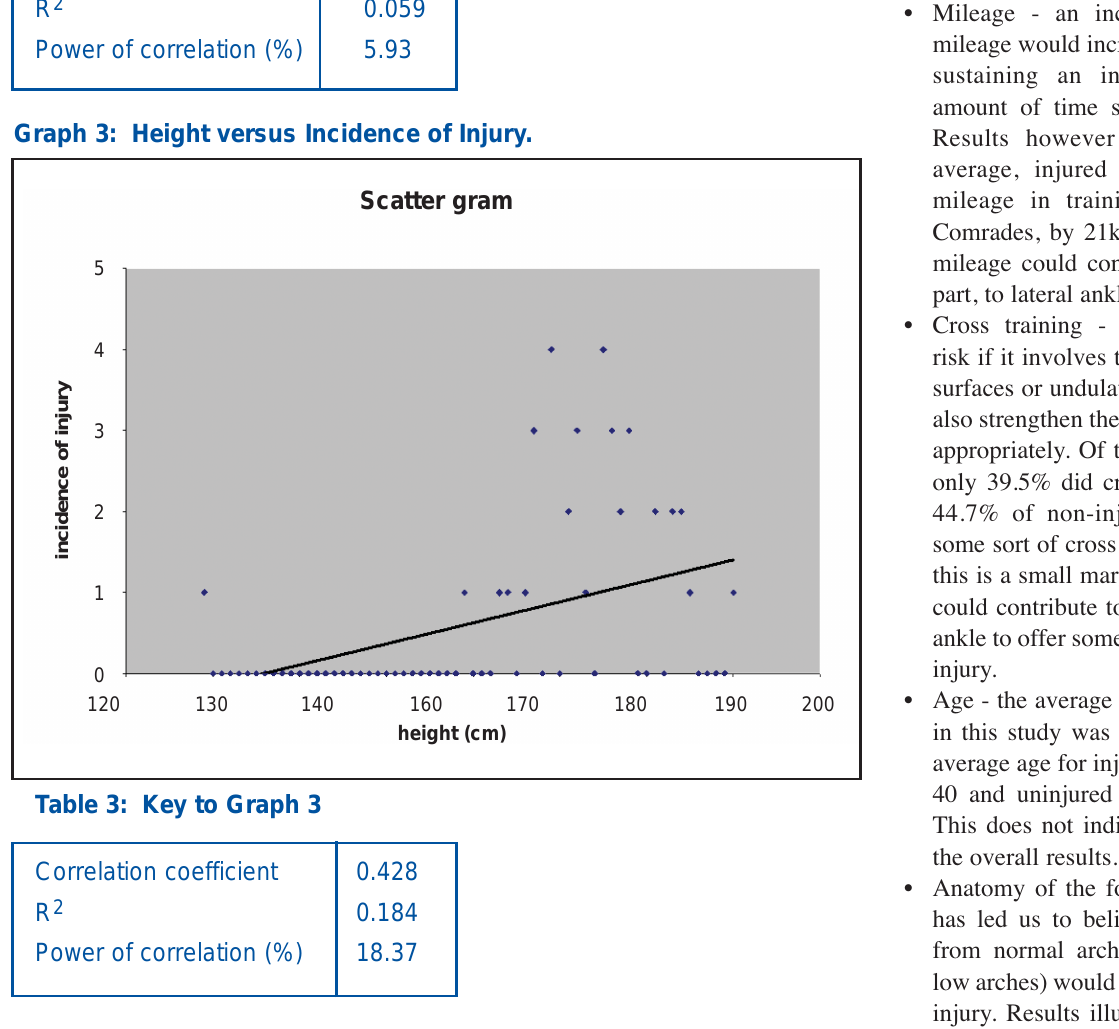
Table 2: Key to Graph 2 Correlation coefficient